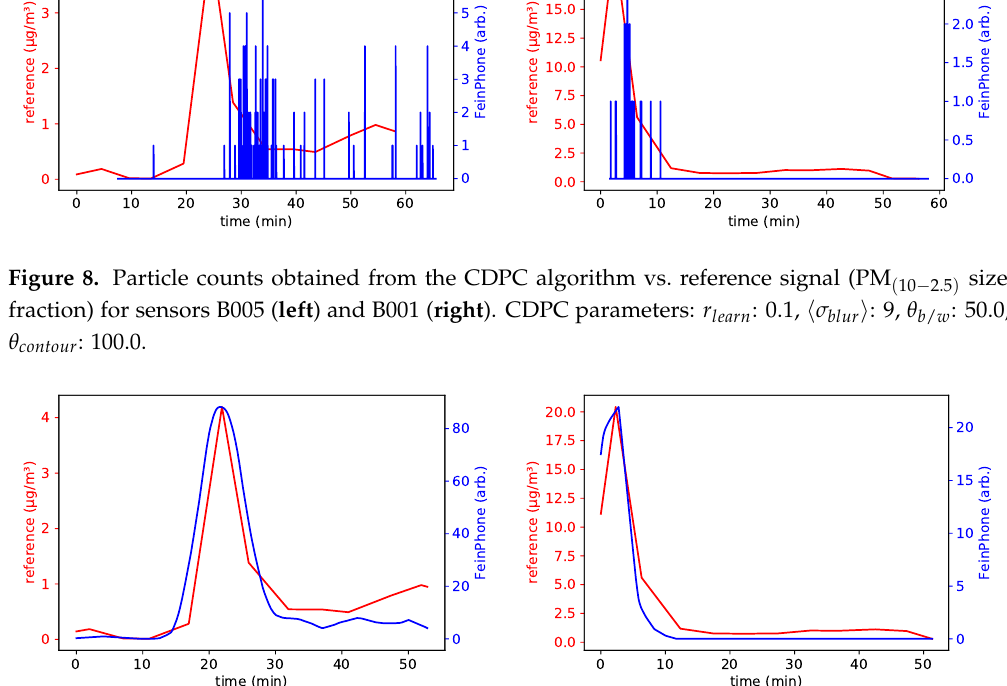
Figure 9. Combined approach: The output from the particle counting (CDPC) algorithm is subsequently piped through the Poisson Particle Detection (PPD). The graphs were shifted to compensate for the time delay caused by the reference method (see above). They show very good qualitative agreement with the PM ( 10 2.5 ) size fraction of the reference, here shown for sensors B005 ( left ) and B001 ( right −